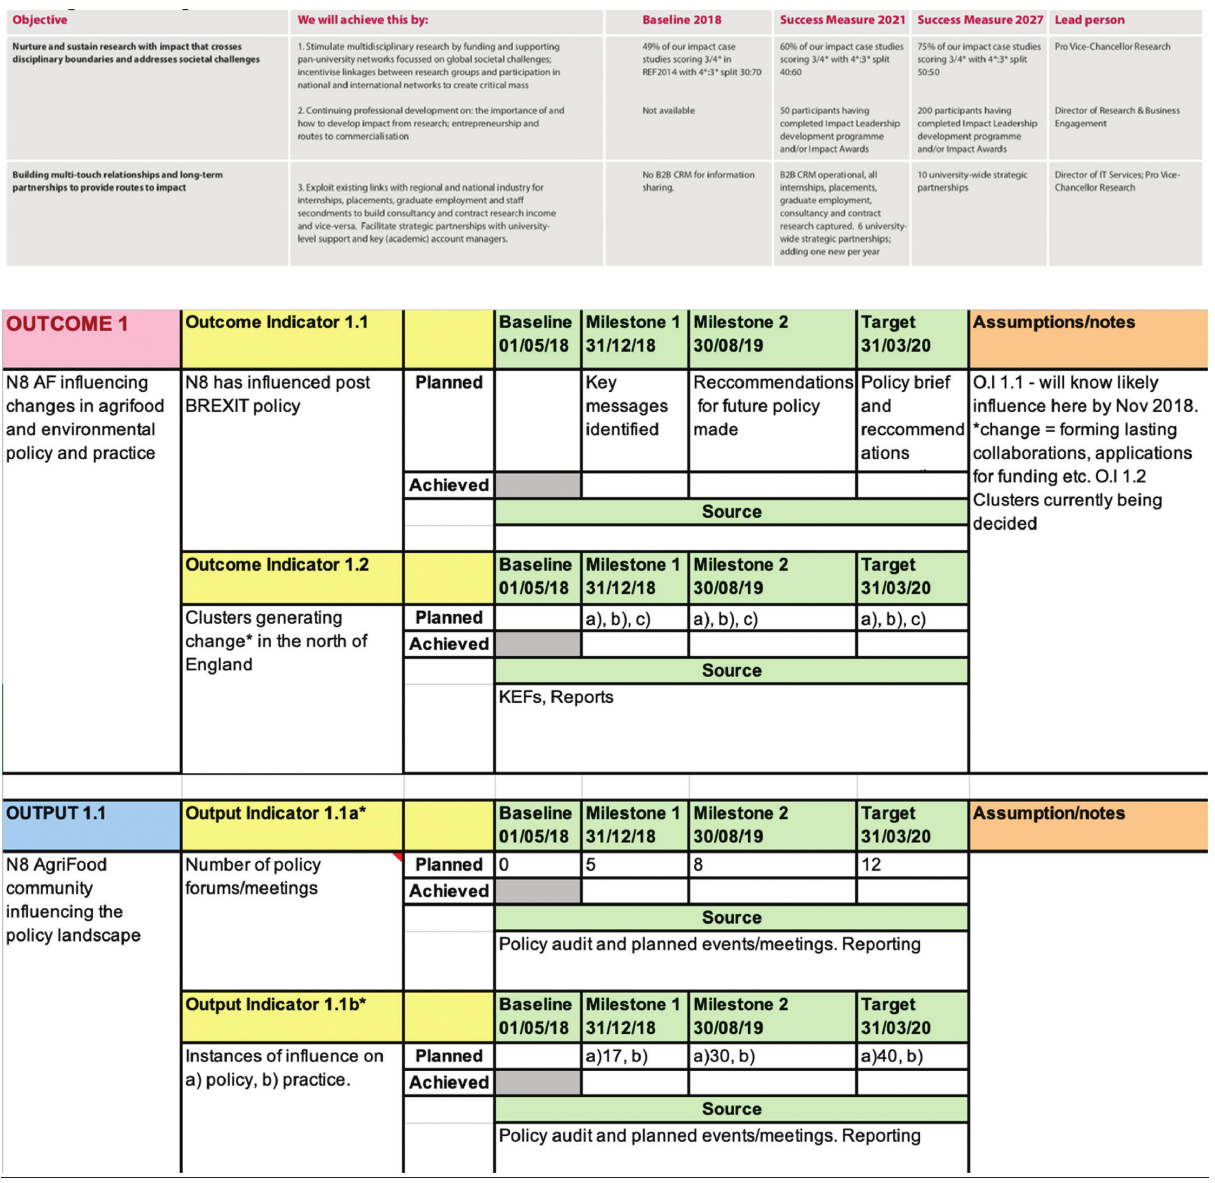
Figure 2. Examples of logic models from the University of South Wales (top) and N8 AgriFood (bottom) (Sources: University of South Wales, Research Strategy 2018–2028; N8 AgriFood Theory of Change and Logic